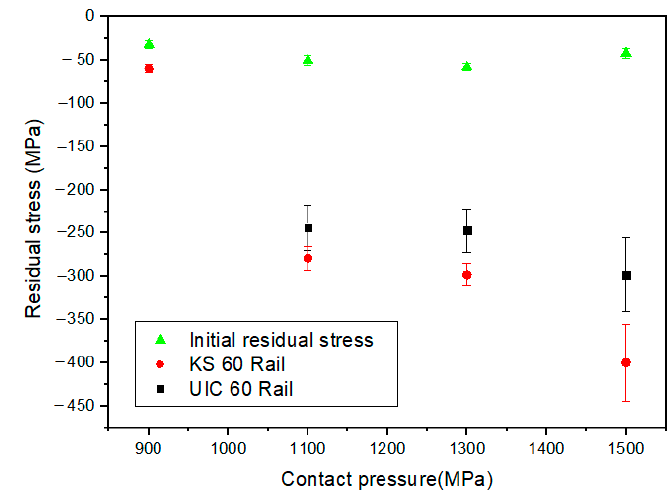
Figure 25. Residual stress variation according to contact stress.